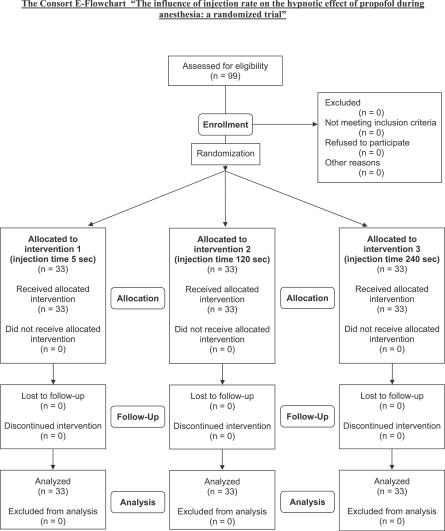
The CONSORT Flowchart Illustrates Patient Enrollment, Allocation, Follow-Up, and Analysis